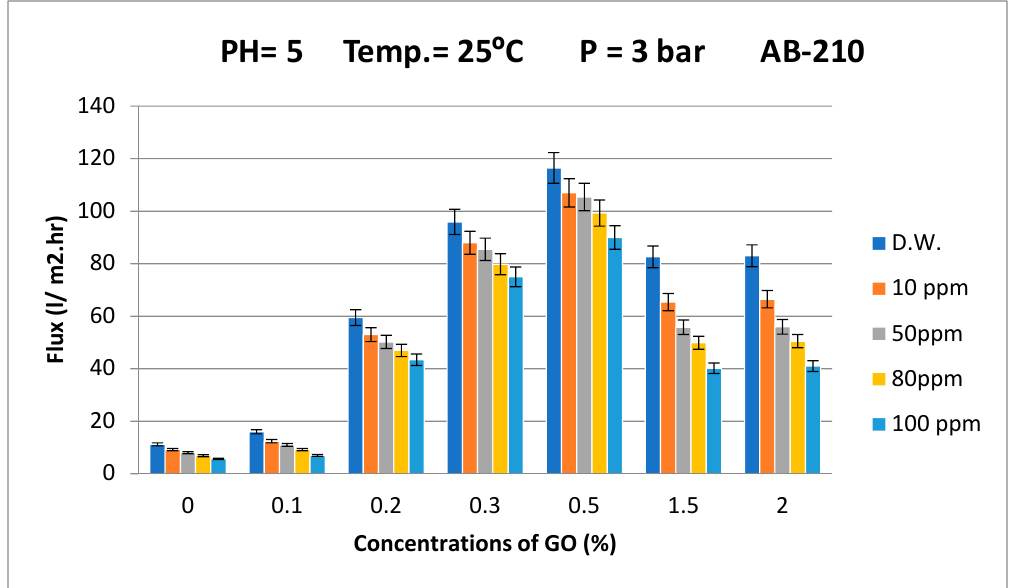
Figure 7. E ff ect of the Acid Black dye concentration in feed solution on the permeation flux of the membrane prepared at di ff erent GO concentrations. The bar height is the average of five measurements of permeation flux and the error bars represent ± one standard